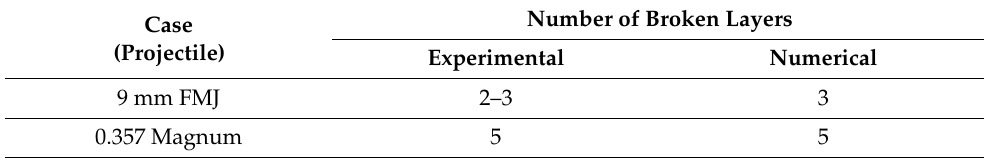
Table 8. Number of broken layers for each case.